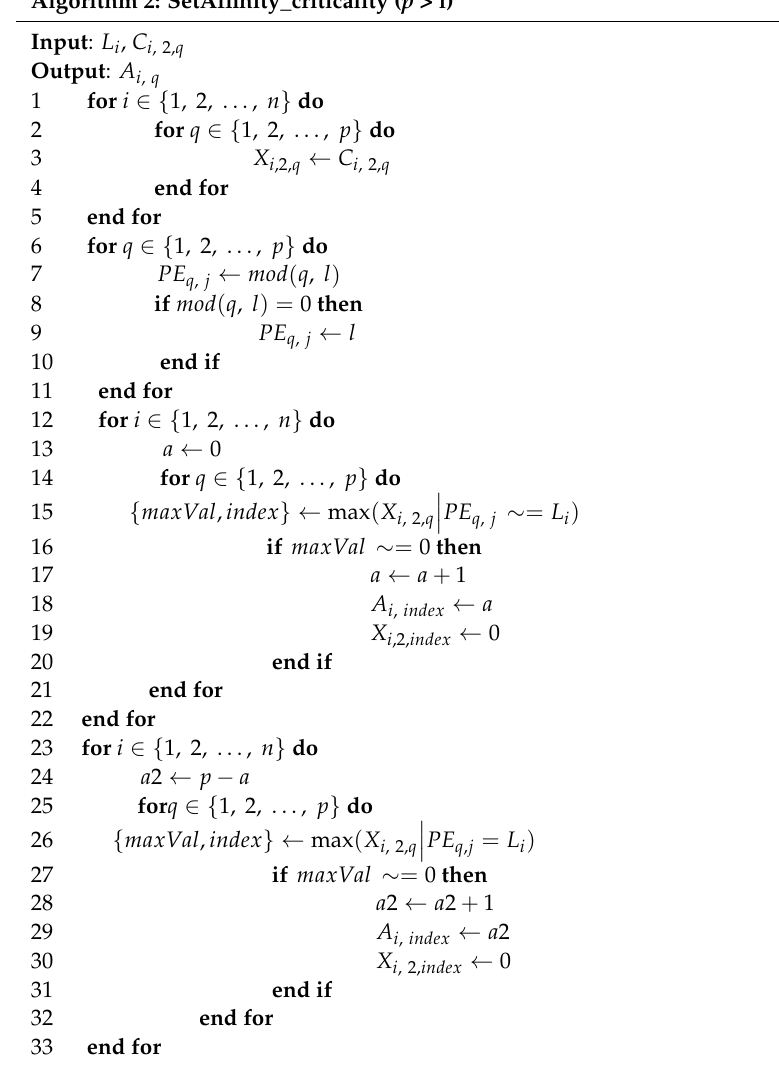
Algorithm 2: SetAffinity_criticality ( p >